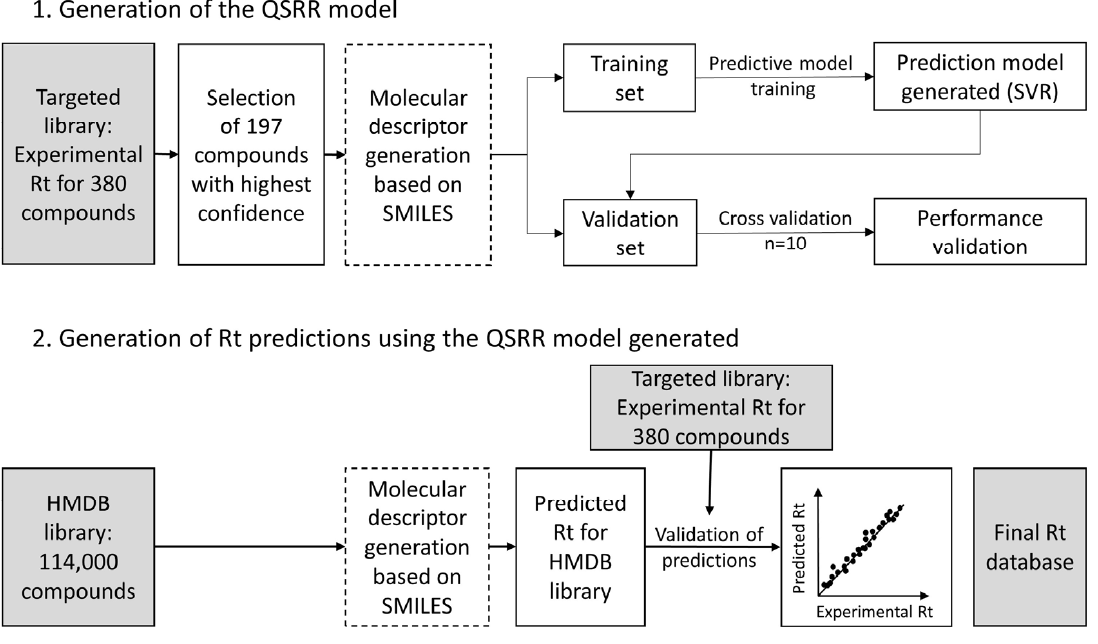
Figure 5. Workflow of Rt prediction.